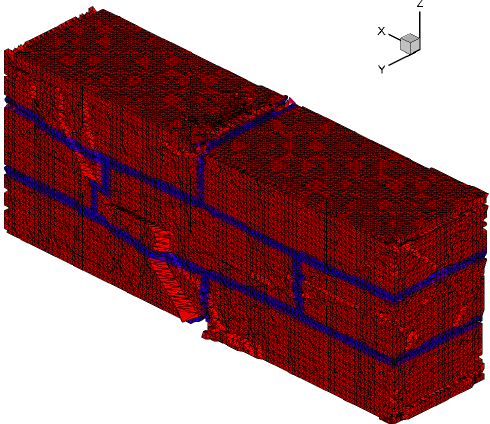
Fig. 3. The configuration of the brick masonry 3×2 is affected by the rectangular impulse with the time duration of 2541,7 ms and at the speed of 6,1 m/s to the time moment of 3000